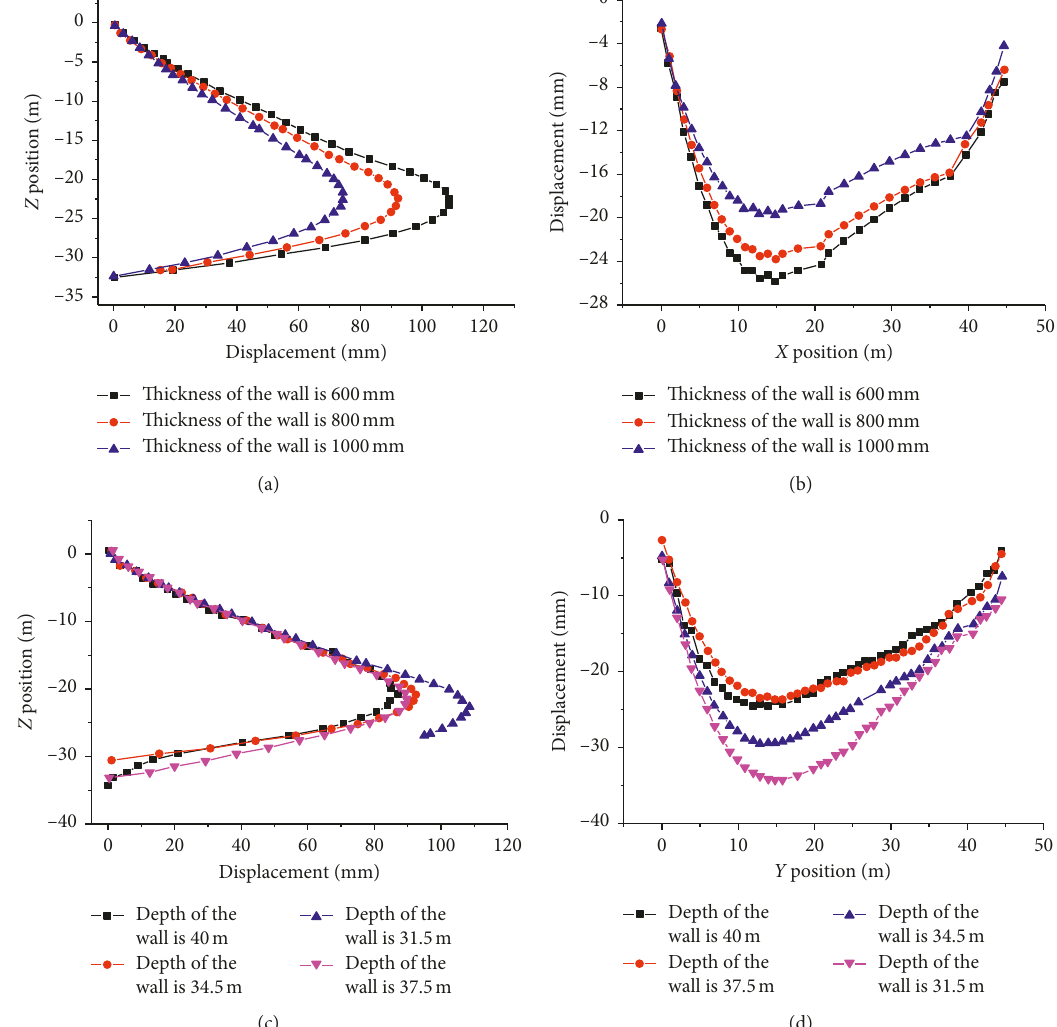
Figure 14: (a) The horizontal displacement of soil adjacent to the diaphragm wall. (b) The vertical displacement of soil adjacent to the diaphragm wall. (c) The horizontal displacement of soil adjacent to the diaphragm wall. (d) The vertical displacement of soil adjacent to the diaphragm